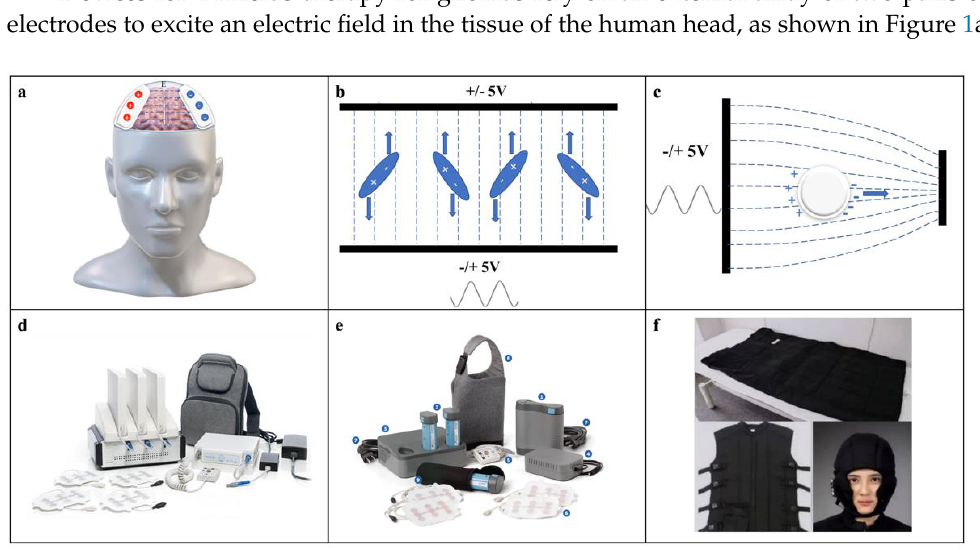
Figure 1. Electromagnetism of TTFields and apparatus used in clinical practice. ( a ) Model of the TTFields device for GBM treatment. ( b ) Electropolar molecules tend to be parallel to the direction of the electric field in an alternating electric field. ( c ) Movement of macromolecules in an inhomogeneous electric field resulting from the dielectrophoretic effect. ( d ) The first-generation Novocure Optune ® system. ( e ) The second-generation Novocure Optune ® system. ( d , e ) Reproduced with permission from Novocure GmbH © 2021 Novocure GmbH — All rights reserved. ( f ) The Electro-Capacitive Cancer Therapy device developed by Warsito at Shizuoka University in Japan; Used with permission.